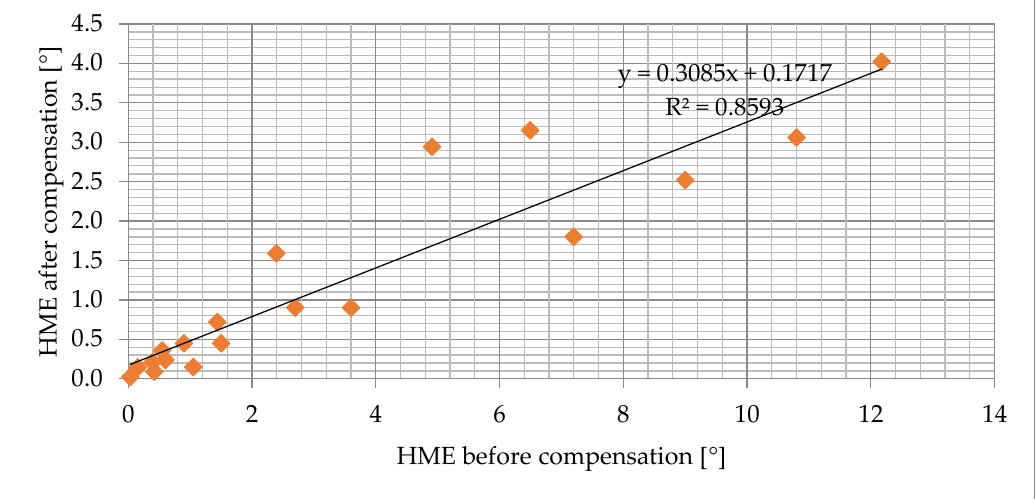
Figure 10. The efficiency of the compensation algorithm, tested on 6 different TMR sensors. The algorithm performs worse on TMR than on AMR sensors. The result is expected because some of the TMR samples hardly fulfill the test for suitability for use with the Lagging-domain algorithm.